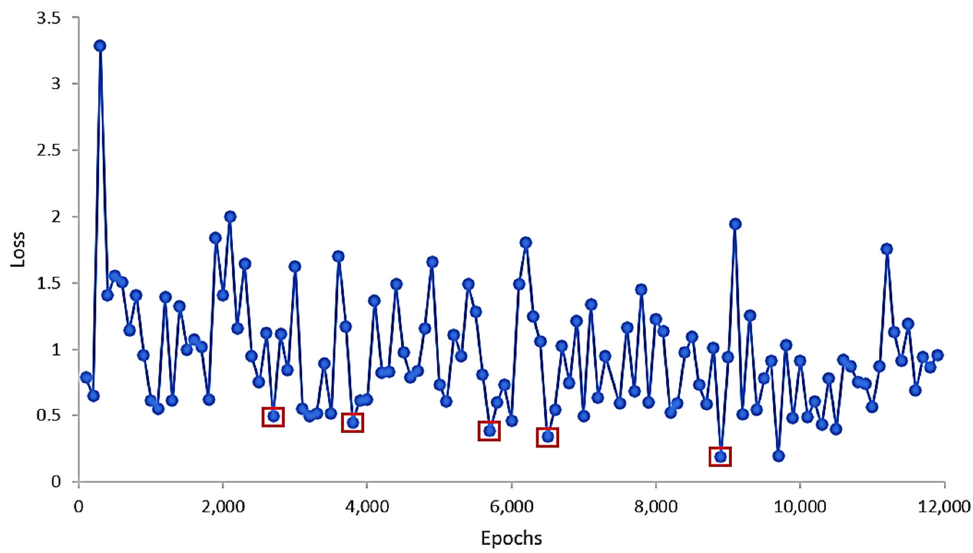
Figure 7. Graph of total loss versus epochs. The red boxes are the lowest loss within each 3,000 epochs.